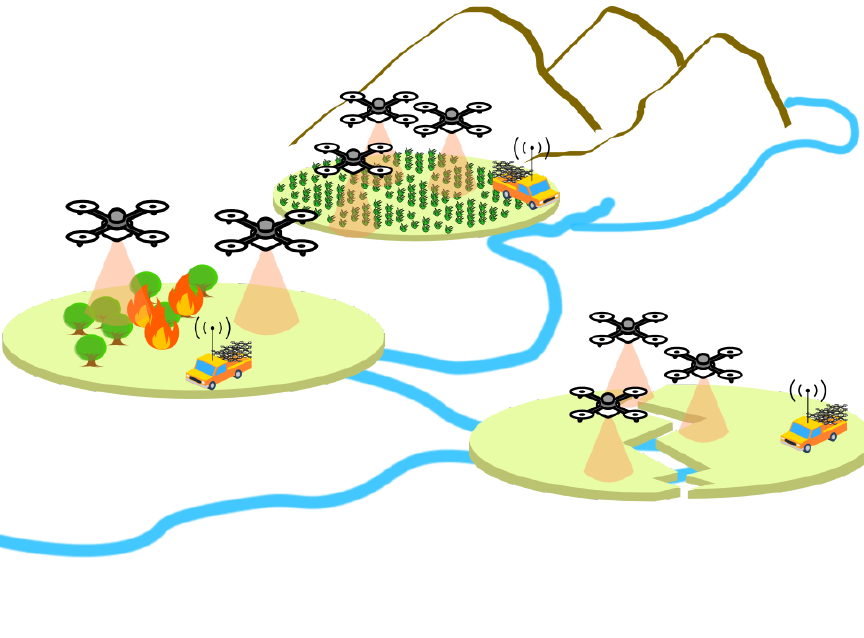
Figure 1. Video dissemination over FANET for disaster recovery